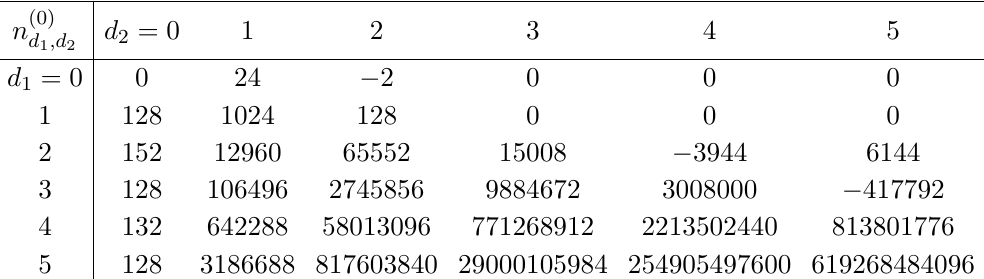
Table 14 . Genus zero Gopakumar-Vafa invariants of the smooth genus one fibration X (4) and the discriminant takes the form ∆ = ∆